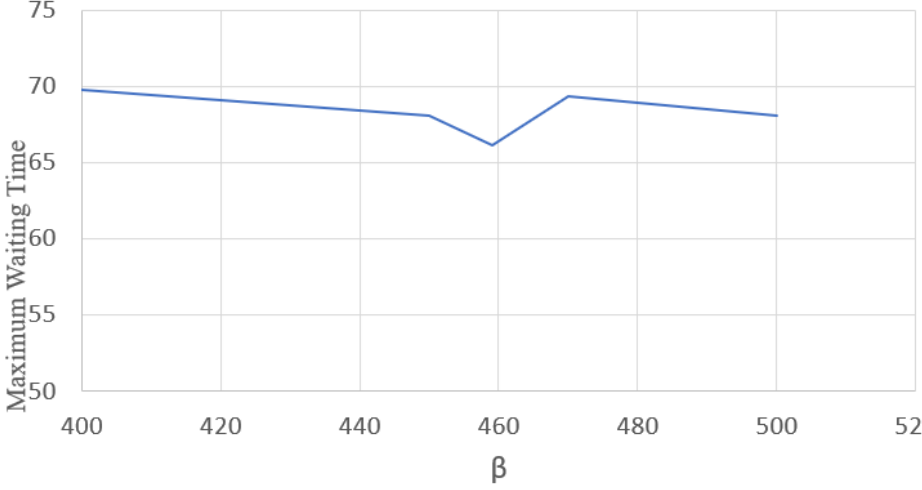
Figure 10. Fairness with different α , β .